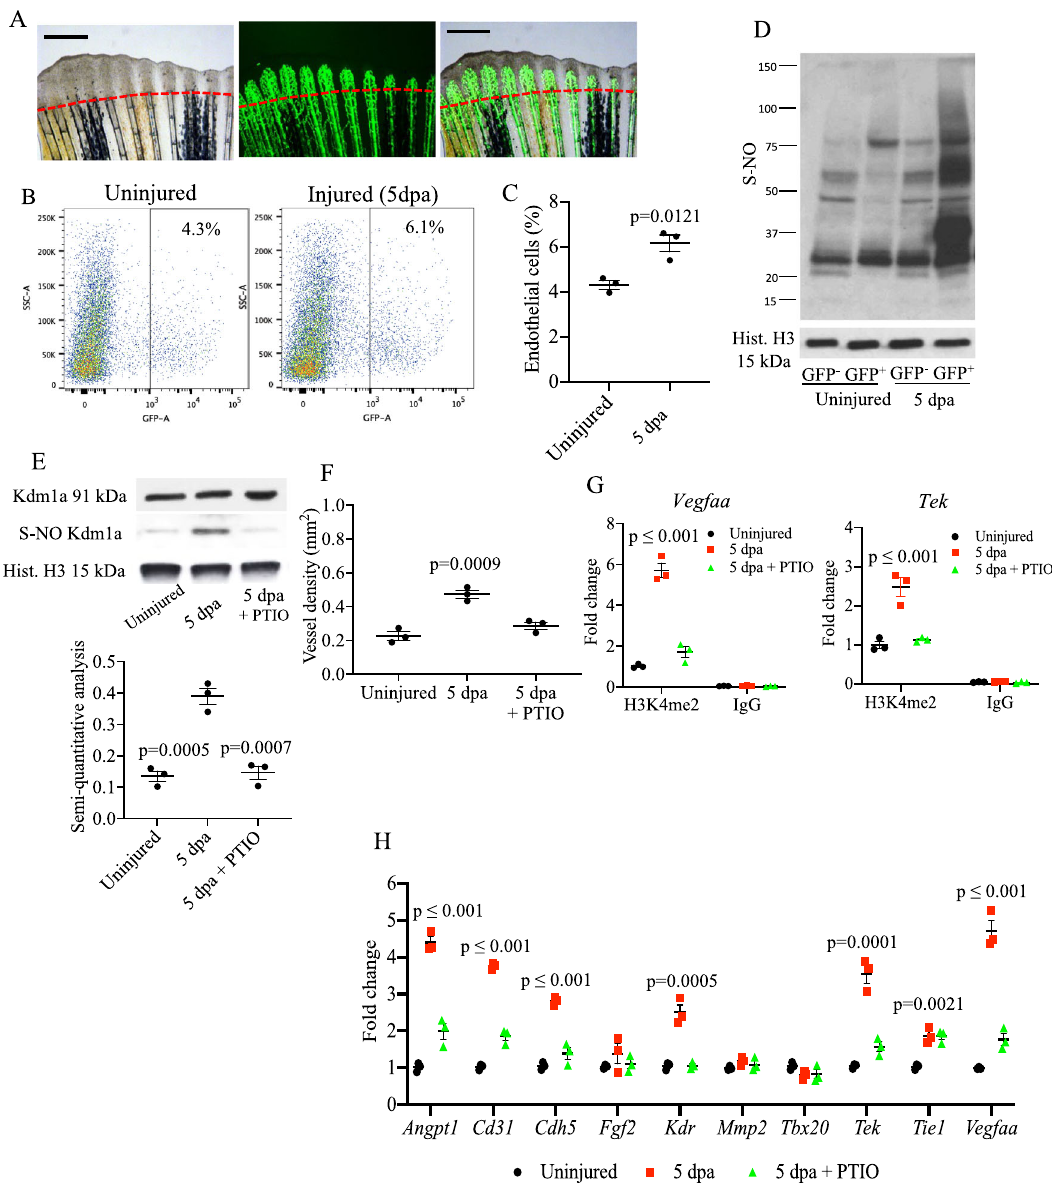
Fig. 5 Analysis of S-nitrosylation in endothelial cells during tail fi n regeneration. A Bright fi eld and fl uorescence images of Tg( fl i1:EGFP) y1 zebra fi sh tail fi n at 3 days post-amputation (dpa) showing formation of new vessel branches (GFP signal). Scale bar measures 500 μ m. B FACS plot of GFP + and GFP − cells in the tail fi n in control and during regeneration were separated by FACS. C Quanti fi cation of GFP + cells as shown in FACS plots. Two-tailed t -test. D Western blotting (WB) of total S-nitrosylated proteins in zebra fi sh tail fi n endothelial (GFP + ) cells. E WB of Kdm1a and S-nitrosylated Kdm1a in endothelial (GFP + ) cells control, injury and injury + PTIO (NO scavenger) 10 mM. Dot plot shows semi-quantitative analysis. p values vs. 5 dpa group. F Vessel density analysis in Tg( fl i1:EGFP) y1 zebra fi sh tail fi n uninjured, injured and injured + PTIO 10 mM, measured as total length of vessels. G ChIP-PCR analysis in GFP + cells isolated from the regenerating tail fi n showing H3K4me2-binding complex with vegfaa and tek promoters. Rabbit IgG were used as a negative control. H Real time PCR analysis for endothelial genes in GFP + cells from zebra fi sh control, injury and injury + PTIO 10 mM. Histone H3 was used as loading control. One-way ANOVA followed by Bonferroni ’ s multiple comparisons test, p values indicate comparisons vs. uninjured. N = 3 biological replicates. Data are presented as mean values + / −